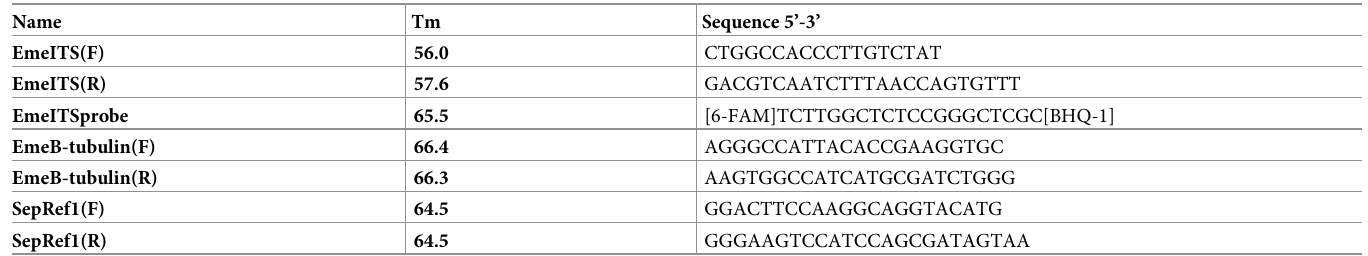
Table 1. The primers and probe used in this